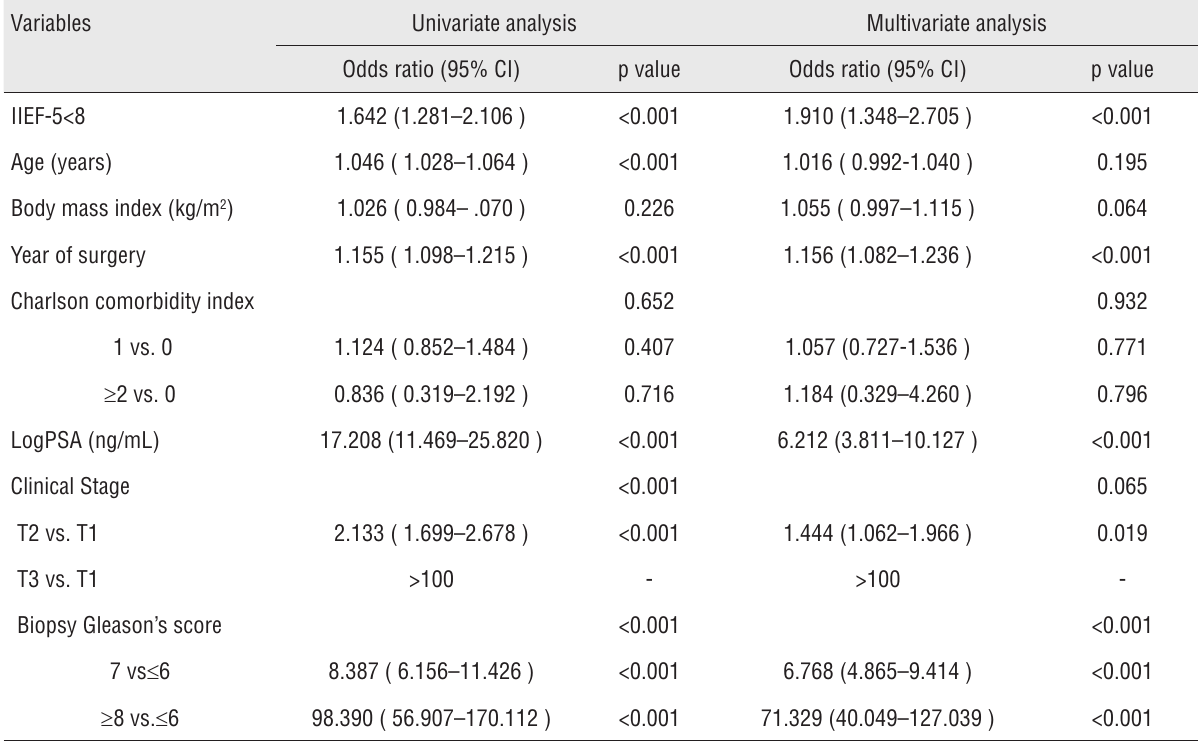
Table-2 - Univariate and multivariate logistic regression analysis to predict high Gleason’s score ( ≥ 7 [4+3]). Variables Univariate analysis Multivariate